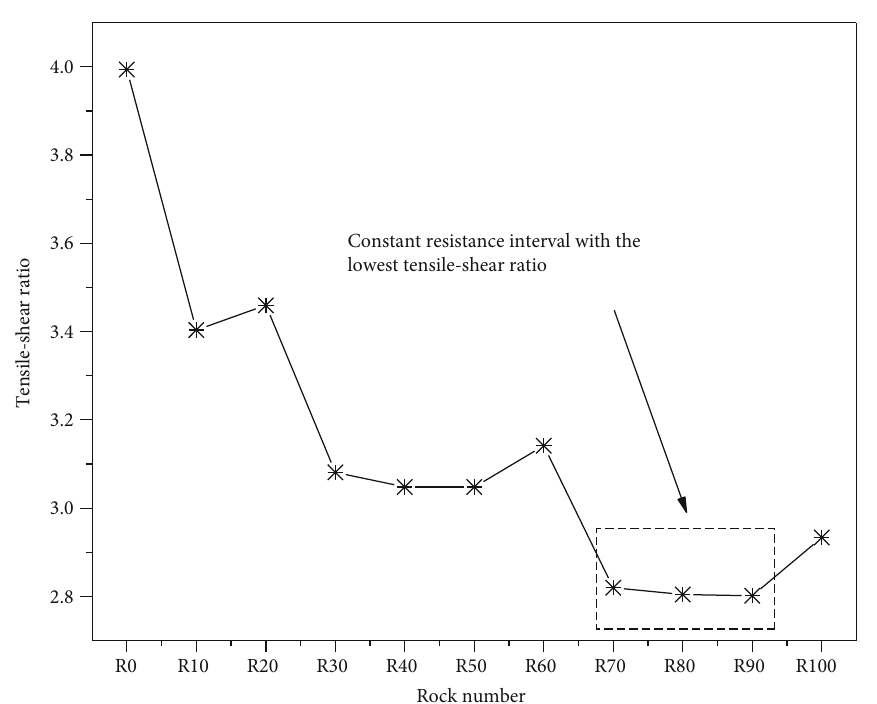
Figure 18: Ratio of tensile and shear